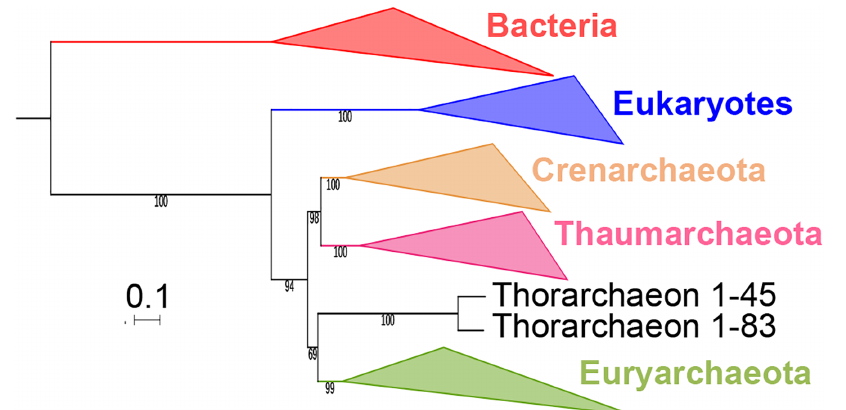
Fig 6. Position of Candidatus Thorarchaeota archaeain the Tree of Life. ML phylogenetic tree of the concatenated alignmentsof the 34 markers present in the two most completethorarchaeal genomes. Detailedtree in S28 Fig. The scale-barrepresentsthe averagenumberof substitutionsper site. Values at nodesrepresent support calculatedby nonparametric bootstrap (out of 100).